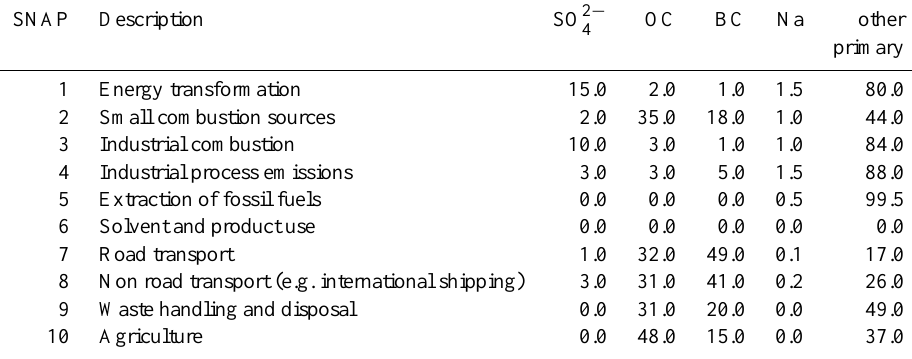
Table 1. Contributions (in % mass) to PM 2 . 5 emissions as used in the TNO/GEMS emission inventory. Sodium (Na) is not used directly in the simulations, but added to the “other primary” category, representing the remaining, non-carbonaceous primary PM 2 . 5 part (including e.g. minerals, metal oxides, product emissions). Sulfate contributions have been calculated assuming 2% of total emitted SO 2 mass (IIASA RAINS emissions for 2000) is H 2 SO 4 for all SNAP categories except SNAP 1 and 3. There, measured compositions of coal fly ash (as dominant contributor to source category) as reported by Lipsky et al. (2002) and Senior et al. (2000) are used as basis. OC depicts organic carbon, a ratio of 1.3 has been used to convert OC to organic aerosol (OA). SNAP Description SO 2 − OC 4